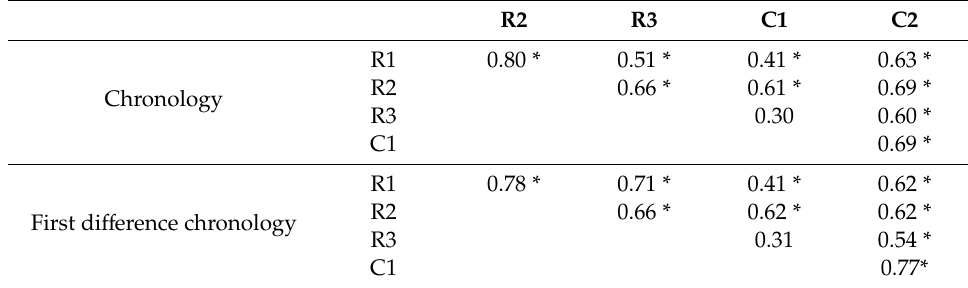
Table 2. Correlation coe ffi cients among chronologies. Correlations were performed during their common period 1979–2016. * indicates that significance level of p < 0.01 is